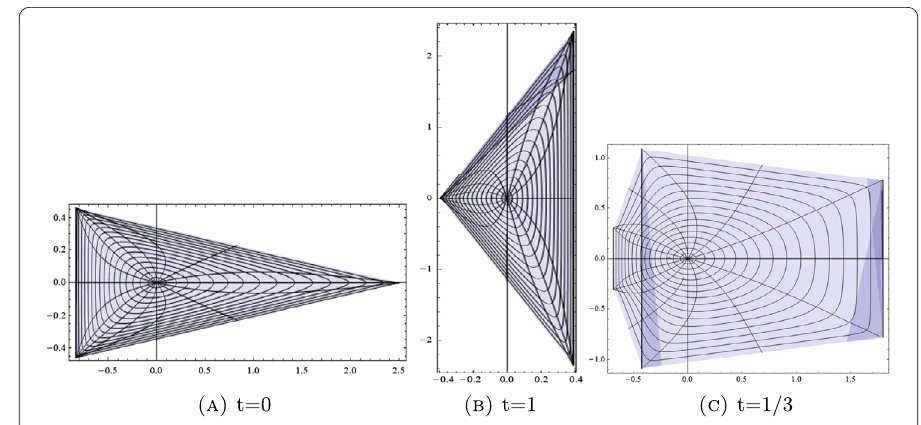
Figure 2 Images of D under f at different values of